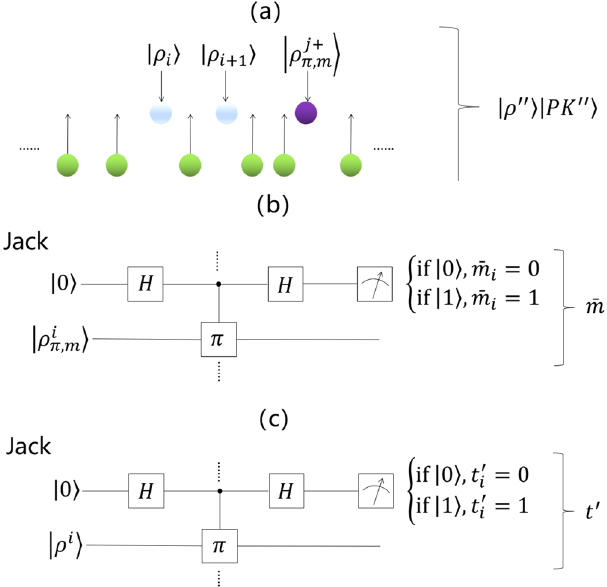
ρ , and | � ρ PK m to obtain | �| � 1 . m i ¯ =